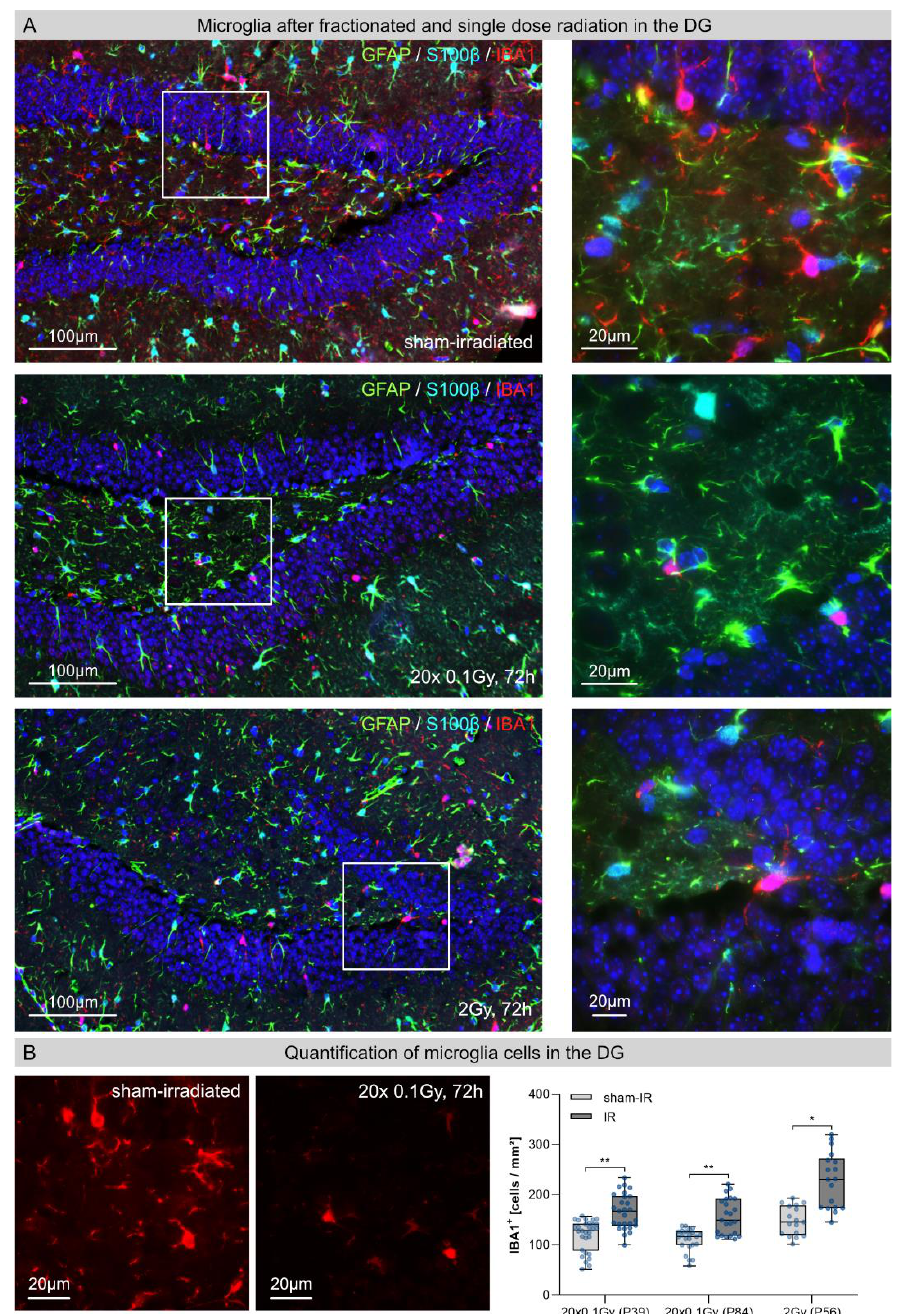
Figure 2. Microglia in the hippocampal dentate gyrus (DG) after fractionated low-dose and single-dose radiation. ( A ): Immunofluorescence micrographs of IBA1+ microglia (red) and GFAP+ (green)/ S100β+ (light blue) astrocytes in the DG of sham-irradiated (upper panel), fractionated low-dose irradiated (20 × 0.1 Gy, 72 h post-IR; middle panel) and single-dose irradiated (1 × 2 Gy, 72 h post-IR; lower panel) brain. Framed regions are shown at higher magnifications. Insets: following FLDR and SDR, activated microglia cells and reactive astrocytes were characterized by altered morphologies. Original magnification: 600×. ( B ): In the DG of juvenile and adult mice, the numbers of IBA+ microglia cells were quantified after 20 × 0.1 Gy versus 1 × 2 Gy (72 h post-IR), in comparison to age-matched, sham-irradiated controls. Error bars represent SEM, n ≥ 3; * denotes statistically significant difference compared to sham-irradiated control: * p < 0.05; ** p <